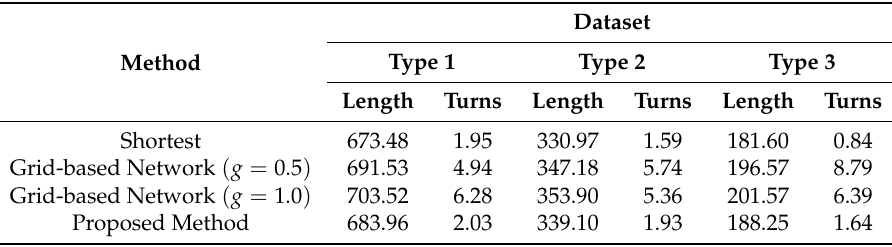
Table 9. Experimental results on the route planning task.